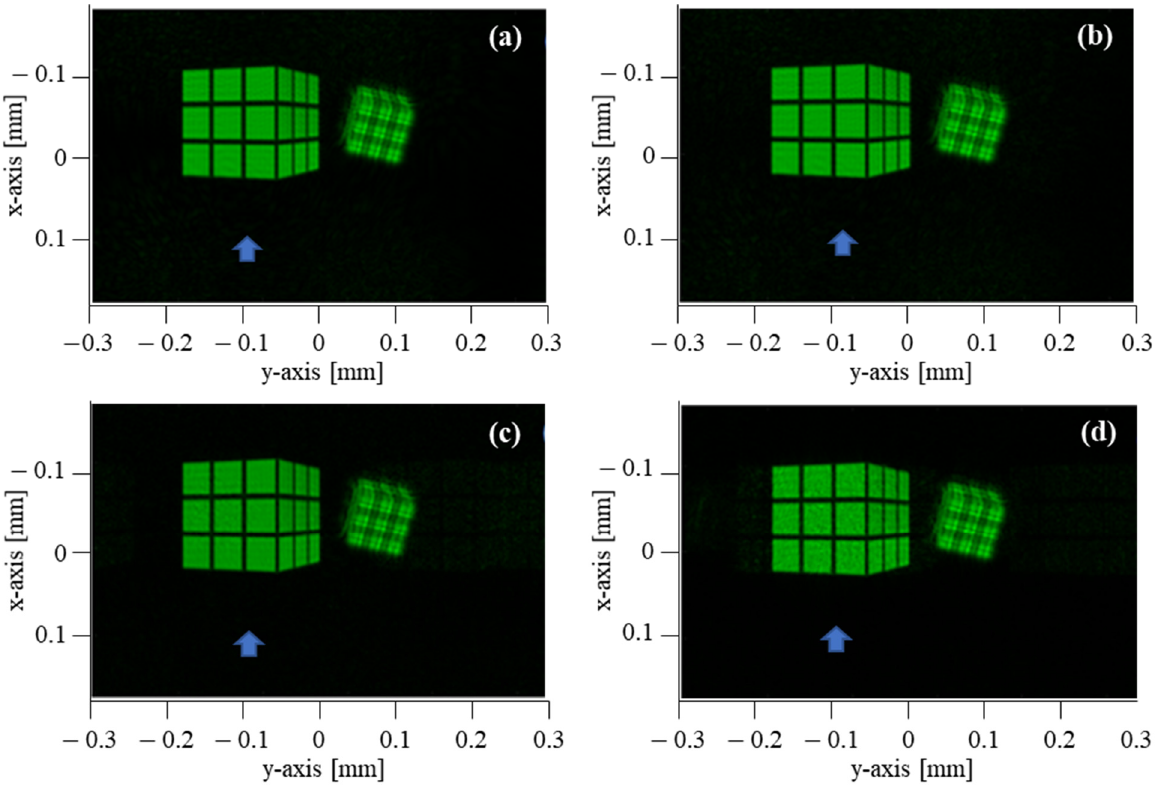
Figure 7. Numerical reconstructions using holograms in the case of CAO encoding ( a ), MAO encoding ( b ), Burckhardt’s encoding ( c ), and Lee’s encoding ( d ) where the left eye of the observer is focused on the front-positioned 3D cube. The object focused is indicated by a blue arrow mark.